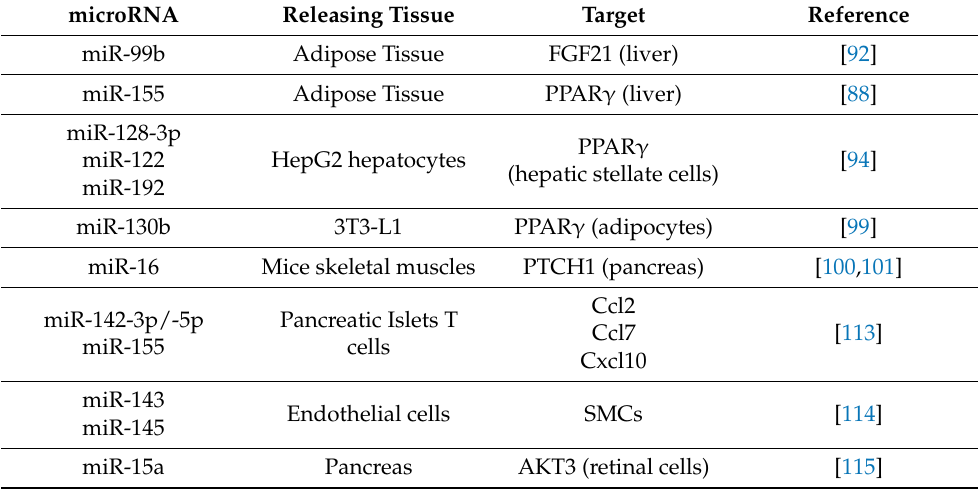
Table 2. Exosomal miRNAs as mediators of interorgan crosstalk in diabetes and